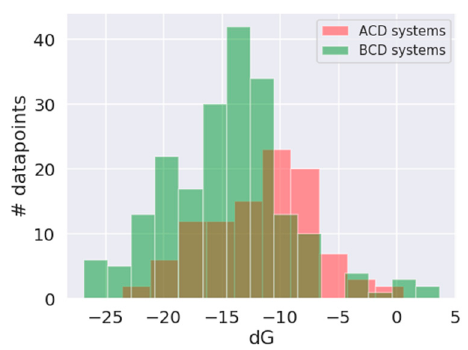
Figure 3. Distribution of dG in the dataset for API– α CD systems (red) and API– β CD systems (green).